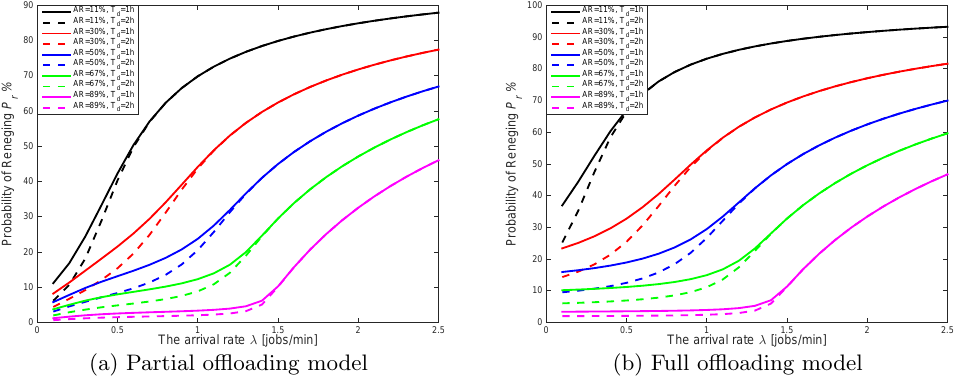
Figure 7: The reneging probabilities for the delayed offloading models